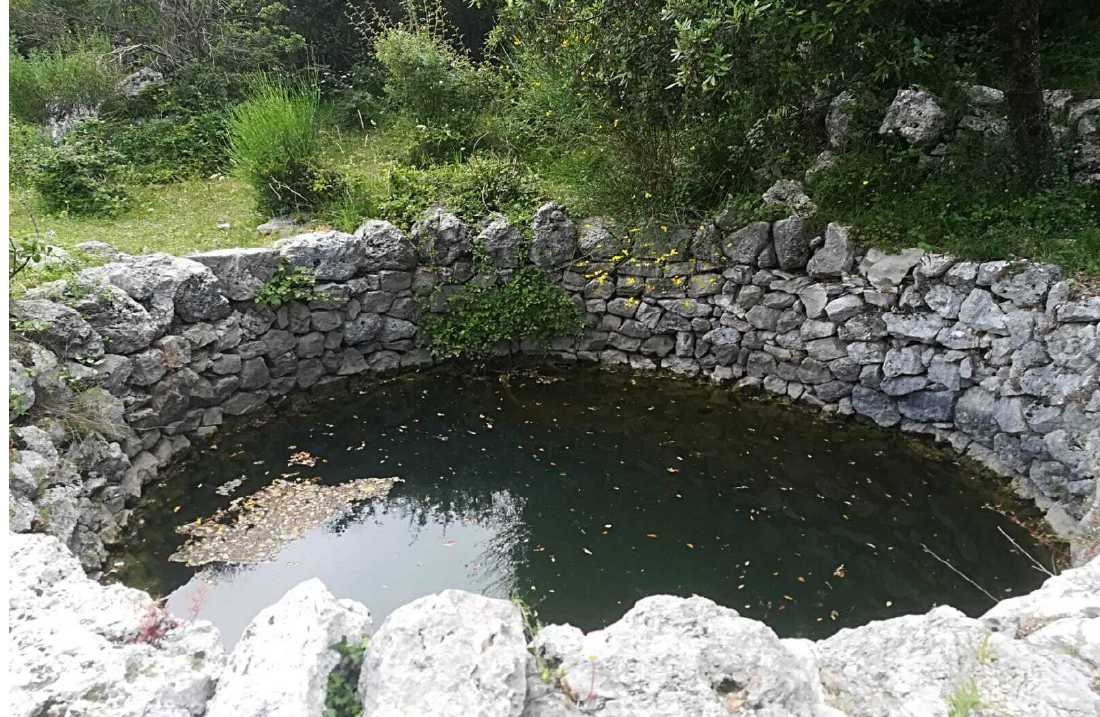
Figure 2. An example of the wells used as water reservoir in the study area. The structure makes them easy to be colonized by newts due their vertical stony walls and the upper margin on the ground level.